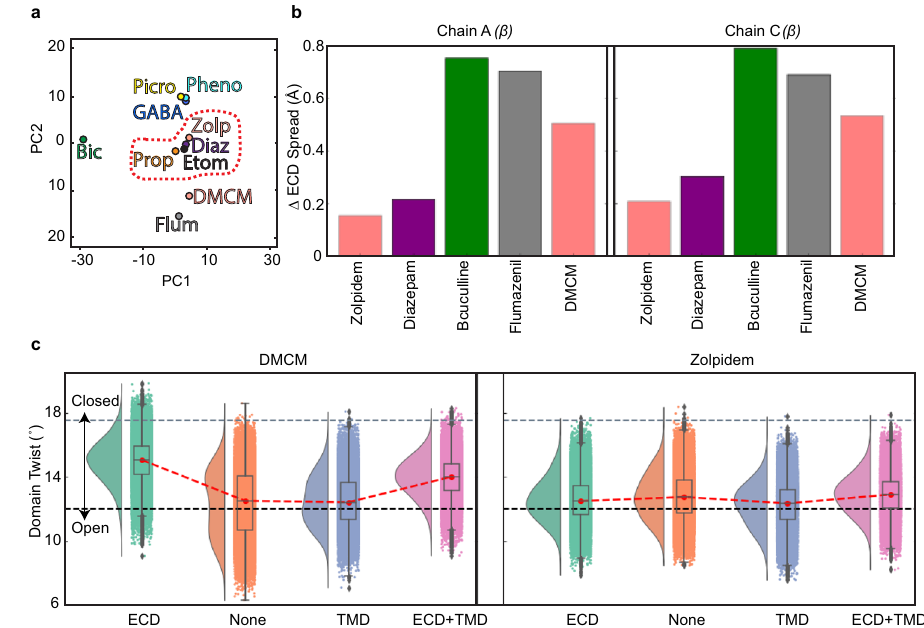
Fig. 5 | Simulations of benzodiazepine-site modulators. a Dominant principal componentsoftheECDsofthezolpidemandDMCMstructurestogetherwiththe8 previously resolved α 1 β 2 γ 2 receptor structures. The cluster formed by the PAMs zolpidem,etomidate,propofolanddiazepamisillustratedwithadottedline. b The ECD spread of β 2 subunits (chains A and C) within structures resolved with PAMs/ NAMsbound,calculatedasthedistancebetweenthesubunit ’ sC α atomscenter-of- mass (COM) and that of the entire structure ’ s ECD. The spread values are nor- malized relative to the spread within the structure resolved with GABA alone structure(PDB6X3Z). c Raincloudplotsquantifyingtherelativeorientationsofthe extracellularandtransmembranedomainsofthe β 2subunitsfromMDsimulations